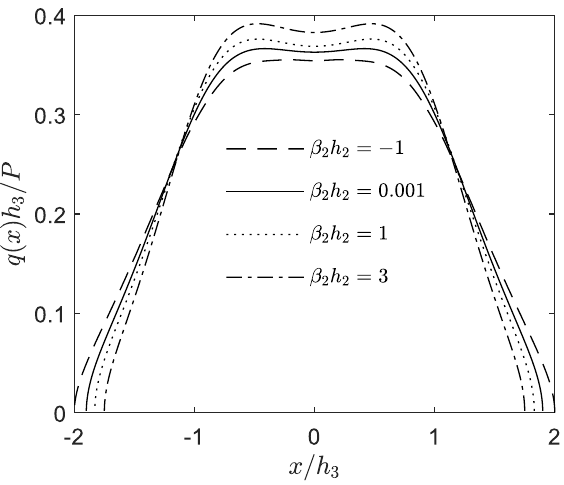
Figure 7. The effects of the inhomogeneity parameter β 2 h 2 on the distribution of the non– dimensionalized receding contact pressure ( µ 03 = µ 1 , h 2 = h 3 , β 3 h 3 = 0.001, a / h 3 = 0.5 )